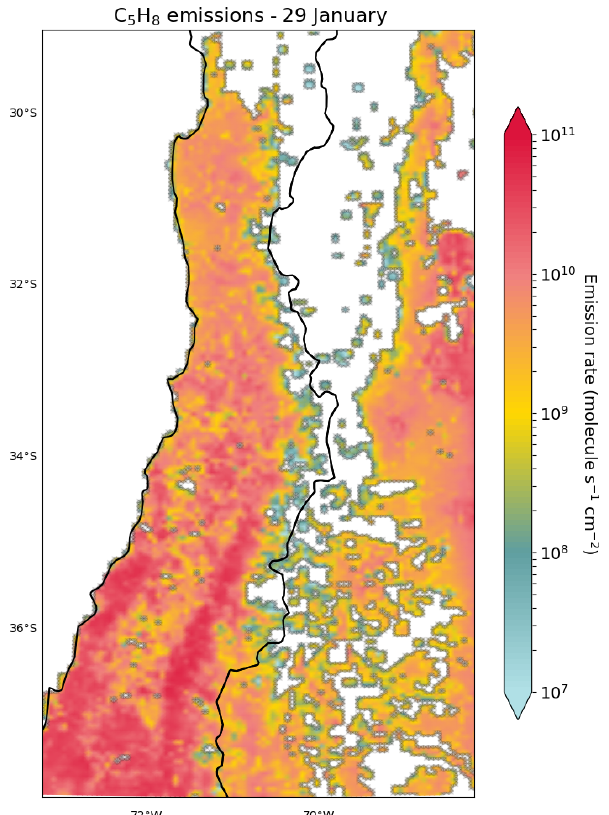
Figure A1. Isoprene (C 5 H 8 ) average emission rate from biogenic sources for 29 January, as computed in CHIMERE using the MEGAN